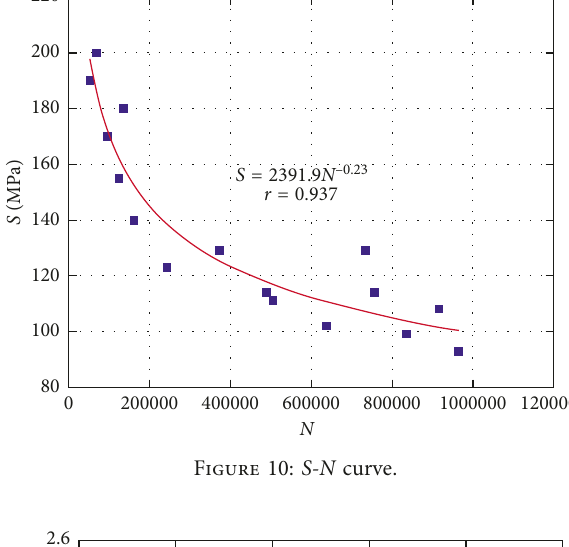
Figure 12: lg S -lg N